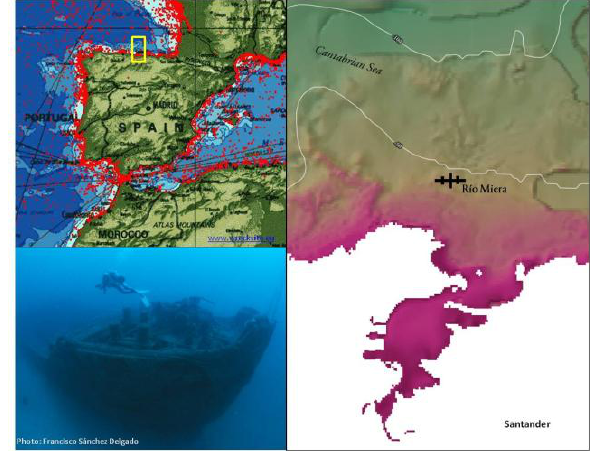
Figure 2: Spain map with wreckships in red points and study area in yellow box; wreck site in the Cantabrian Sea; and an photograph of Río